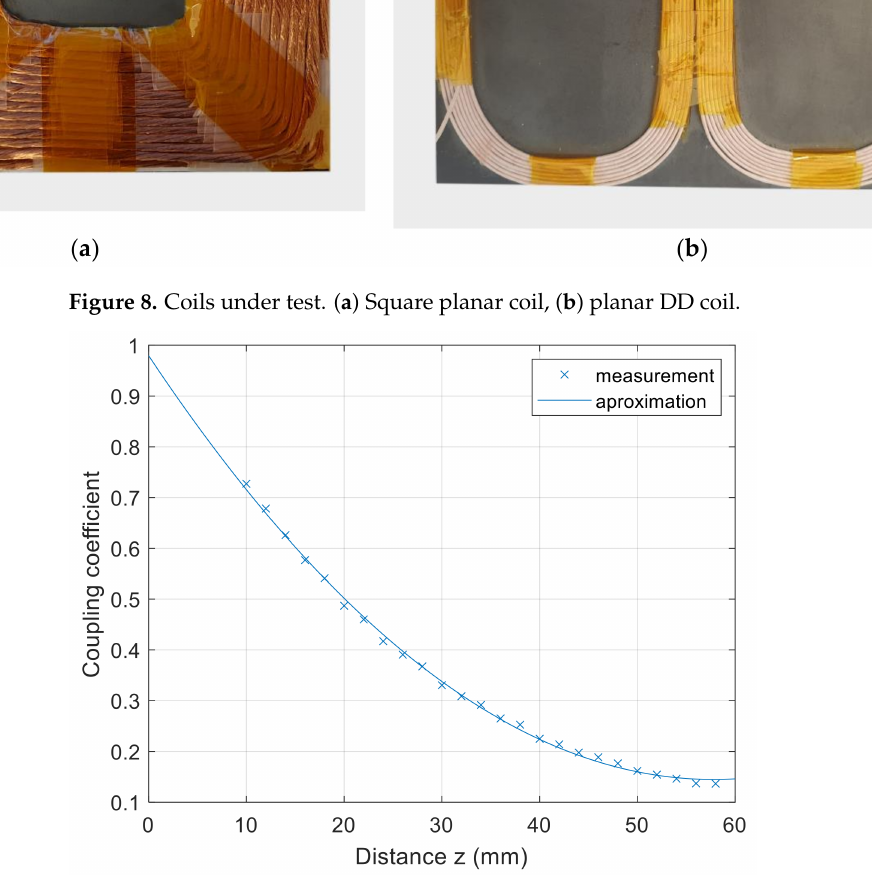
Figure 9. z -axis coupling coefficient measurement of planar square